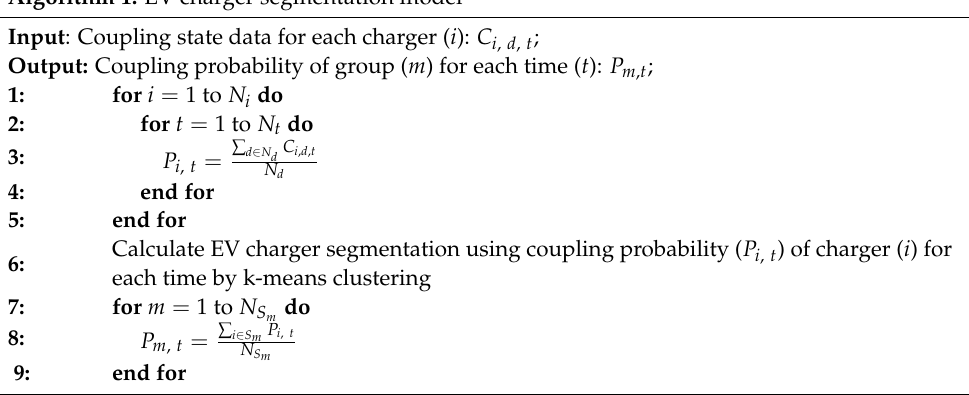
Algorithm 1: EV charger segmentation model